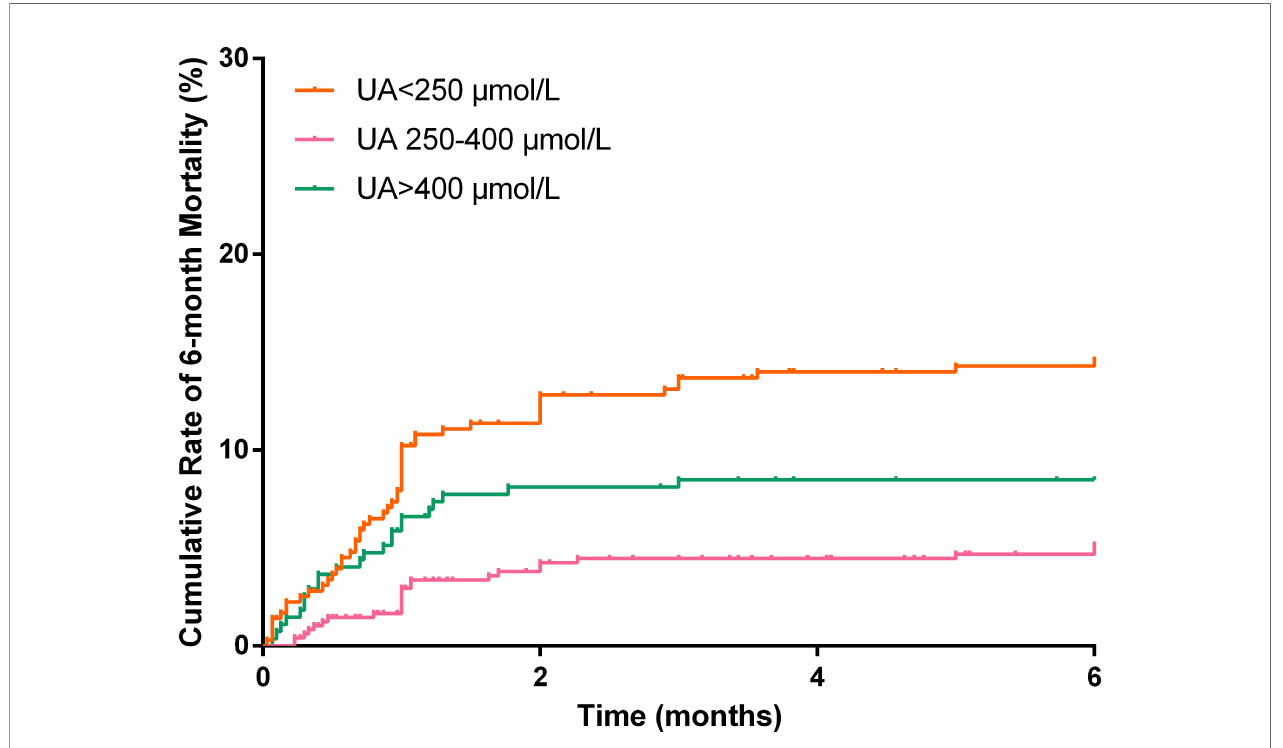
FIGURE 4 | Cumulative rate of 6-month mortality according to different uric acid